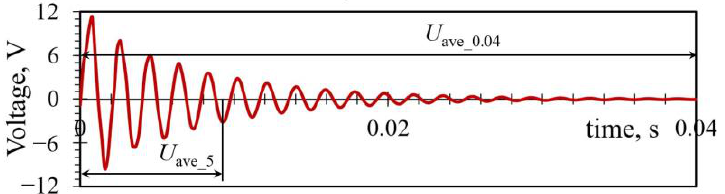
Figure 7. Residual analyses for P p-p_max : normal probability plot ( a ), residuals vs. the fitted value plot ( b ), frequency vs. residuals graph ( c ) and dependence of the residuals on the observation order ( d ).